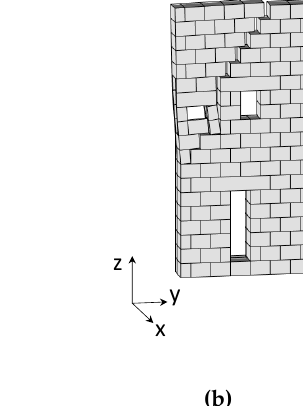
Table 1. Numerical and analytical load factors for the out-of-plane analysis of the four façade macro- elements.